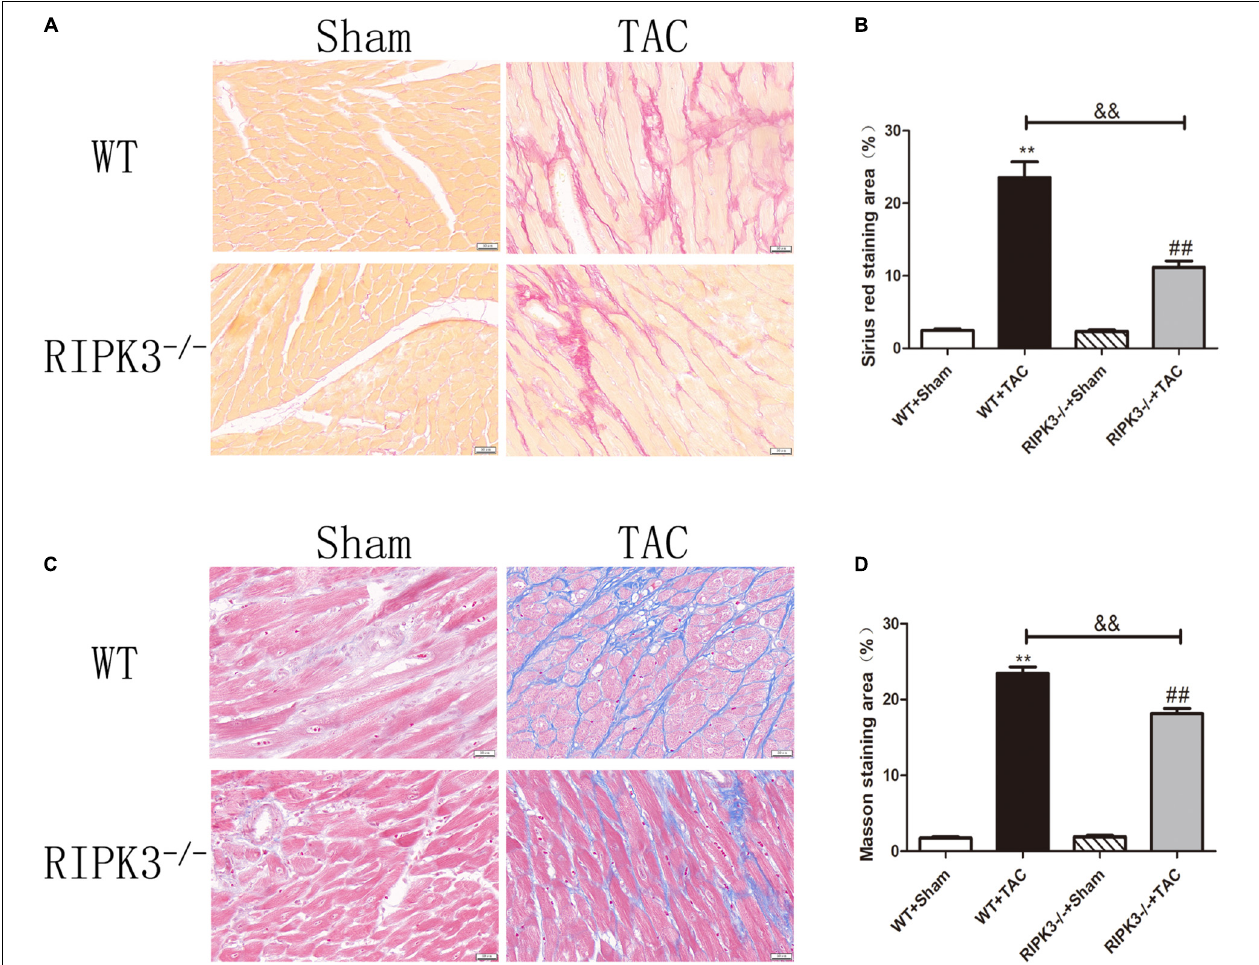
FIGURE 5 | Depletion of RIPK3 can improve the degree of collagen deposition and myocardial fibrosis in HF mice. Male 8-week-old WT and RIPK3 − / − mice were treated with TAC using a 28-g needle. The control group received sham surgery. All groups of mice were given continuous feeding for 6 weeks. Hearts were then obtained for correlative testing. (A) Sirius red staining, bar = 50 µ m. (B) Sirius red staining area measurements. (C) Masson staining, bar = 50 µ m. (D) Masson staining area measurements. Compared with WT + sham group, ** P < 0.01; compared with RIPK3 − / − + sham group, ## P < 0.01; compared with WT + TAC group, && P < 0.01. n =